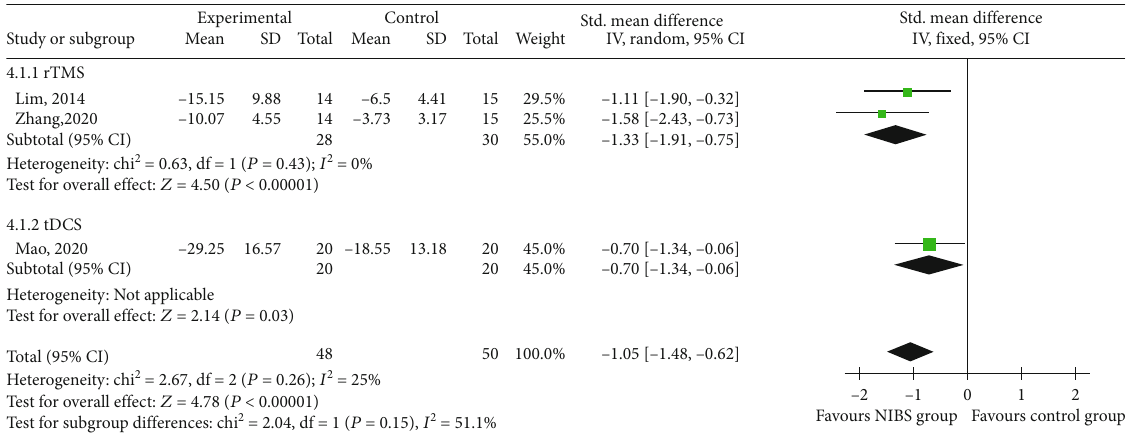
Std. mean difference IV, fixed, 95%